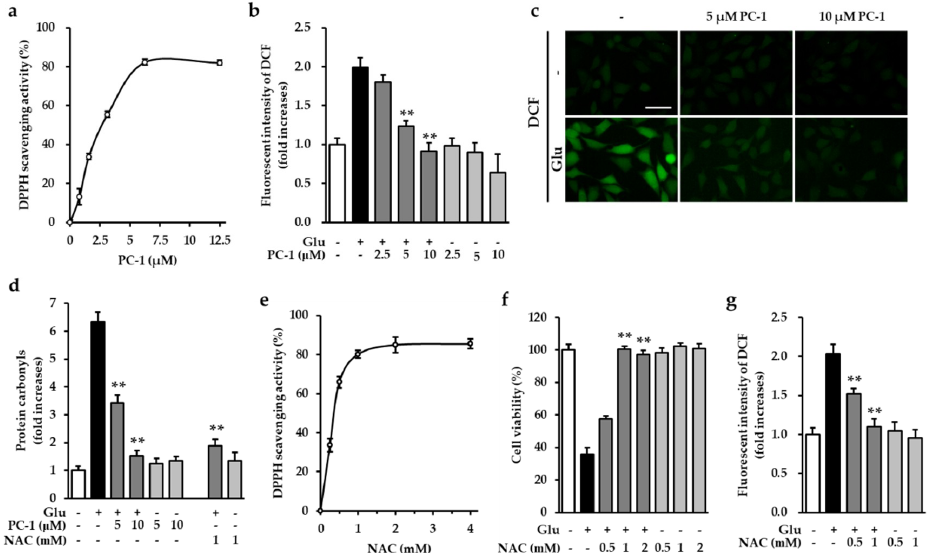
Figure 4. Procyanidin C1 prevented glutamate-induced oxidative stress in HT22 cells. ( a ) We assayed antioxidant activity using a 2,2-diphenyl-1-picrylhydrazyl (DPPH) radical-scavenging activity assay. Lines indicate the percentage of DPPH scavenging activity. ( b ) HT22 cells were exposed to 5 mM glutamate in the presence or absence of 5 or 10 µM PC-1 for 8 h and stained with H 2 DCFDA. The fluorescent intensity of DCF was measured using a fluorescent microplate reader. Bars denote the fold-increase of intracellular reactive oxygen species (ROS) levels. Data were represented by the mean value ± S.E.M. ** p < 0.001 versus glutamate-treated HT22 cells. ( c ) Representative fluorescent images were obtained using a fluorescent microscopy. Scale bar, 50 µm. ( d ) HT22 cells were incubated for 8 h with 5 mM glutamate in the presence or absence of PC-1 or N-acetyl-cysteine (NAC) and determined protein oxidation (mean ± S.E.M. ** p < 0.001 versus glutamate-treated HT22 cells). ( e ) Lines indicate the percentage of DPPH scavenging activity of NAC, as a positive control. ( f ) As a positive